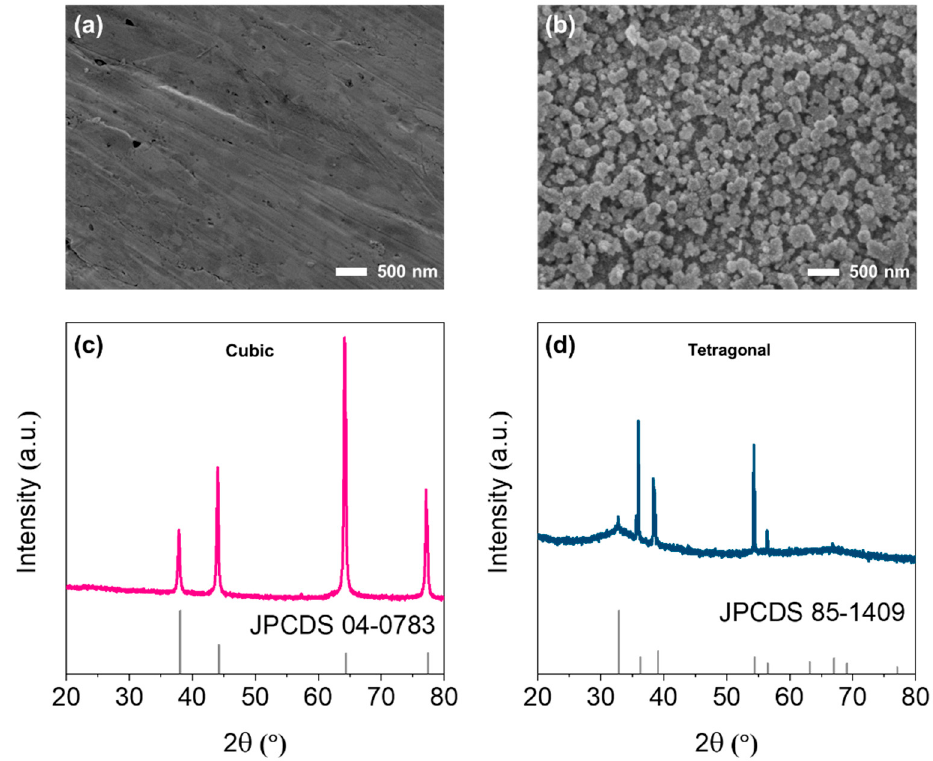
Figure 2. Morphology and crystal structure. SEM images of ( a ) Ag and ( b ) In. XRD patterns of ( c ) Ag and ( d ) In. Spectra are plotted versus the equivalent Cu K α 2 θ diffraction angle.